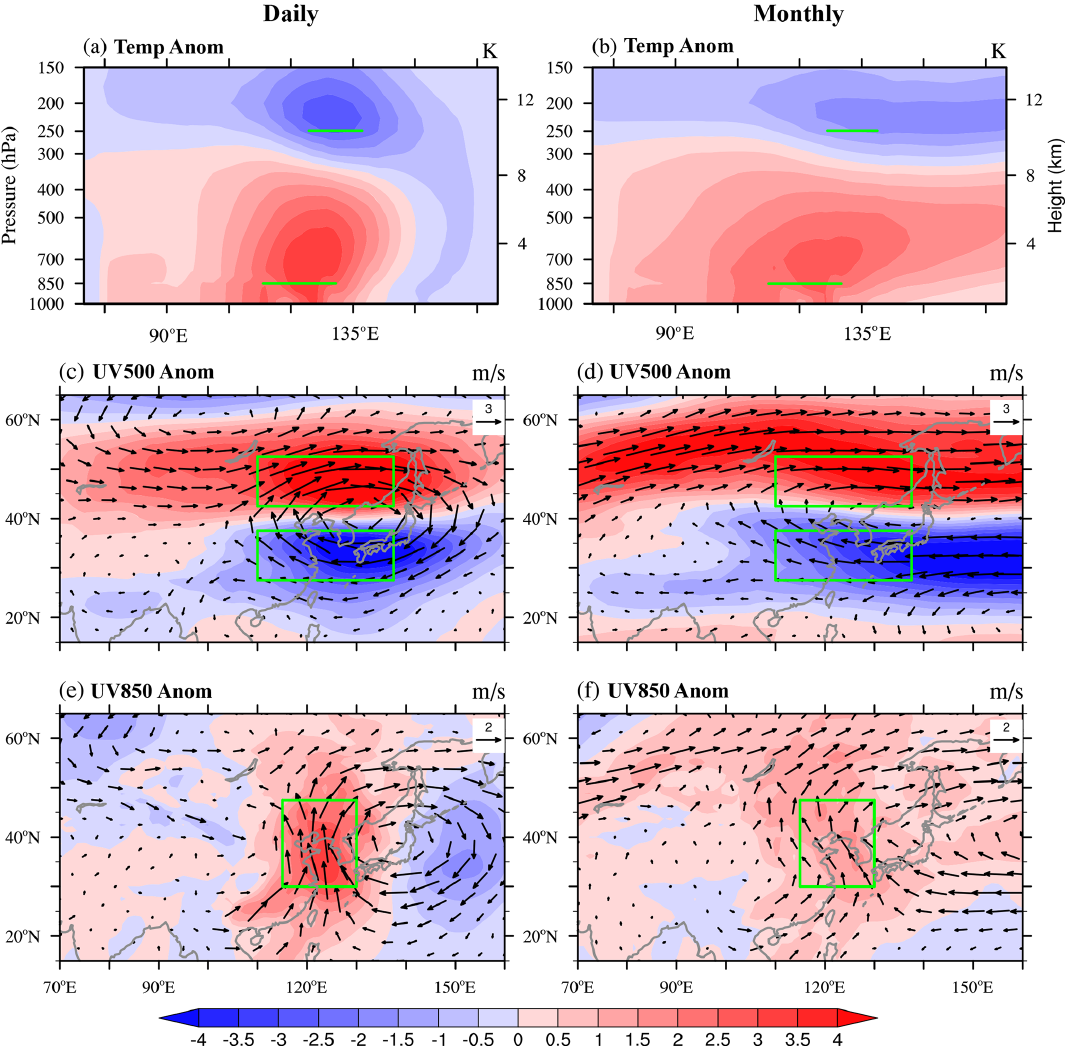
Figure 1. Composite circulation anomalies from JRA-55 with HWI-daily > 0 (a, c, e) and HWI-month ≥ 1 (b, d, f) for 1958–2013. (a, b) Temperature (K) along 40 ◦ N; (c, d) 500hPa winds (vector, ms − 1 ) and their zonal component (shading, ms − 1 ). Panels (e, f) : 850hPa winds (vector, ms − 1 ) and their meridional component (shading, ms − 1 ). The green boxes and lines indicate the regions used to calculate the three components of